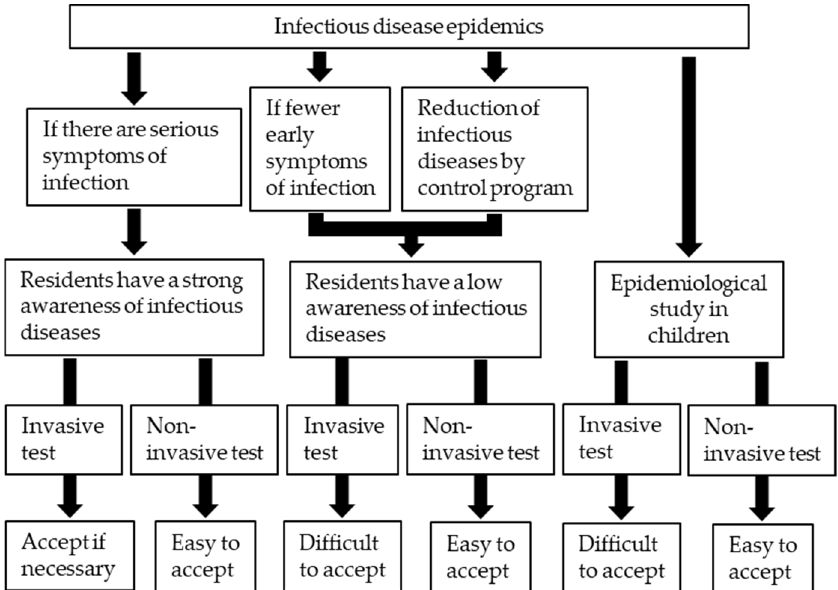
Figure 1. Characteristics of infectious diseases and tolerance of subjects to invasive and noninvasive tests in epidemiological studies.